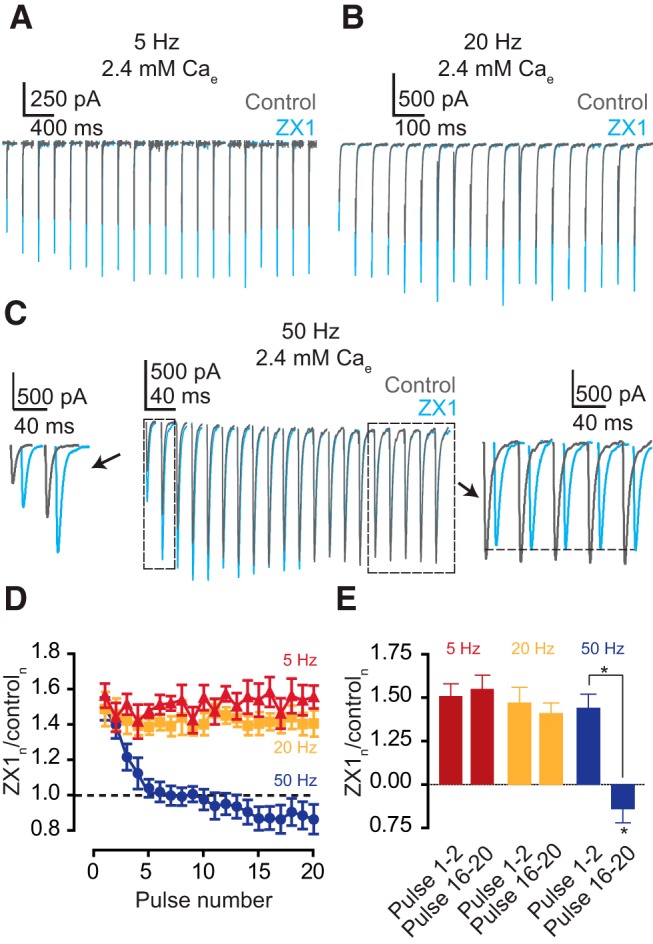
Frequency- and history-dependent effects of synaptically released zinc on AMPA EPSCs. A–C, Representative traces of cartwheel cell AMPA EPSCs evoked by 20-pulse train stimulation of parallel fiber at 5 Hz (A), 20 Hz (B), and 50 Hz (C middle panel), before (grey) and after 100 µM ZX1 (blue); (C side panels) same as in upper panel but zoomed on the first 2 pulses (left) and the last 5 pulses (right). For improved visualization, responses after ZX1 are slightly shifted to the right. D, Summary graph showing the ratio of AMPA EPSCs in ZX1 to that in control at each pulse at 5 Hz (maroon), 20 Hz (orange), and 50 Hz (blue). E, Summary graph comparing the ratio of AMPA EPSCs in ZX1 to that in control for the first two and last five pulses in the 20-pulse train at 5 Hz (maroon, n = 10, p = 0.82), 20 Hz (orange, n = 10, p = 0.63), and 50 Hz (blue, n = 10, p < 0.01). Values represent mean ± SEM. Detailed values and statistical tests: D, E, ZX1–2/control1–2 vs. ZX16–20/control16–20: 5 Hz: 1.51 ± 0.07 vs. 1.55 ± 0.08, n = 10, p = 0.82, t = 0.24, df = 9; 20 Hz: 1.47 ± 0.09 vs. 1.41 ± 0.06, n = 10, p = 0.63, t = 0.49, df = 9; 50 Hz: 1.44 ± 0.07 vs. 0.86 ± 0.08, n = 10, p < 0.01, t = 5.45, df = 9; paired t-tests; ZX1–2/control1–2: 5 Hz vs. 20 Hz, p = 0.65, t = 0.46, df = 9; 5 Hz vs. 50 Hz, p = 0.38, t = 0.92, df = 9; 20 Hz vs. 50 Hz, p = 0.68, t = 0.42, df = 9; ZX16–20/control16–20: 5 Hz vs. 20 Hz, p = 0.09, t = 1.87, df = 9; 5 Hz vs. 50 Hz, p < 0.01, t = 5.09, df = 9; 20 Hz vs 50 Hz, p < 0.01, t = 4.98, df = 9; paired t-tests; AMPA EPSC amplitudes16–20: control: 50 Hz: 1.00 ± 0.00 vs. ZX1: 0.86 ± 0.08, p = 0.042, t = 2.36, df = 9; one-sample t-test.